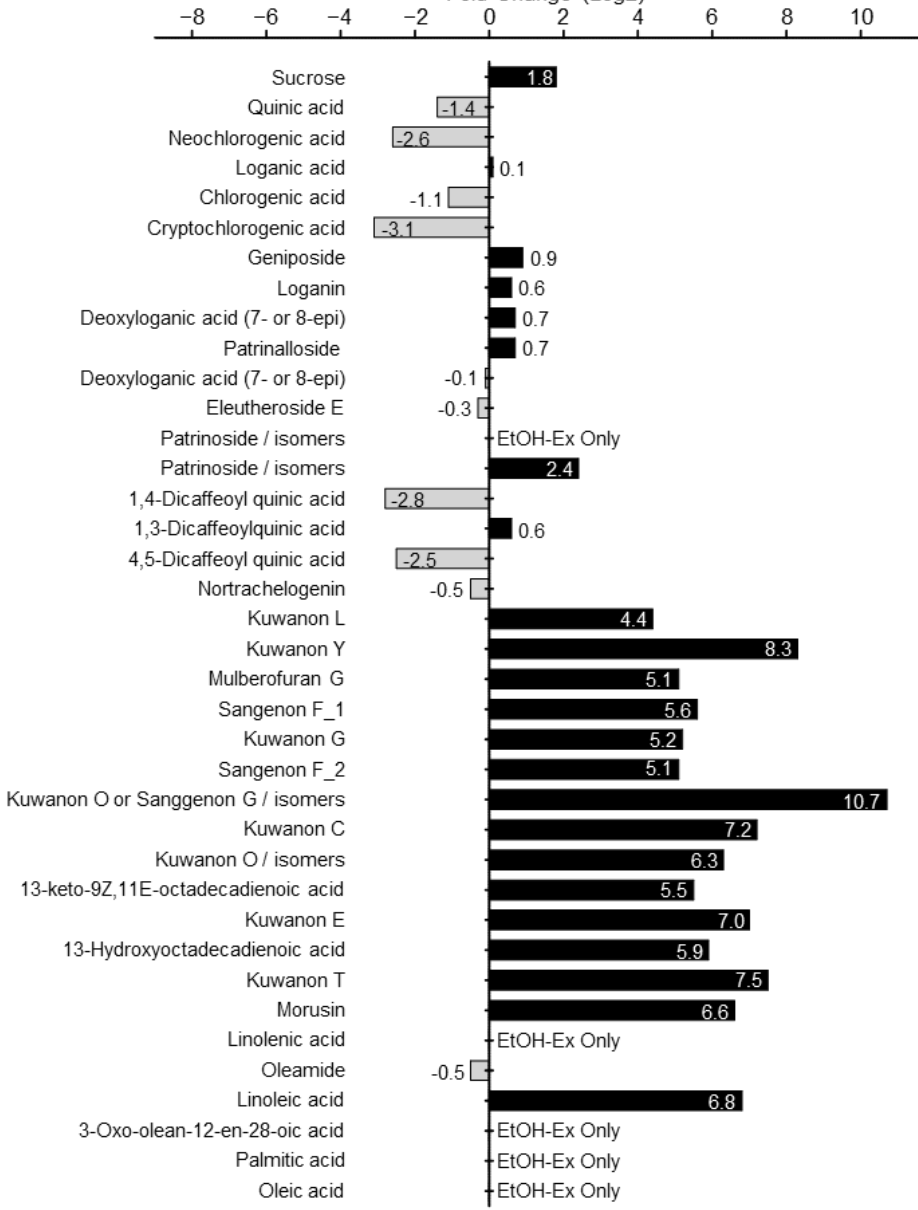
Figure 8. Identification of PSY EtOH-Ex-enriched phytochemicals. Peak area fold change of 38 compounds from PSY EtOH-Ex and Water-Ex. Fold change > 0 means that the relative content of chemical compounds in EtOH-Ex is higher than Water-Ex. The fold changes in peak area were calculated using the formula log2 for the ratio of peak area values of the phytochemicals extracted by different solvents.